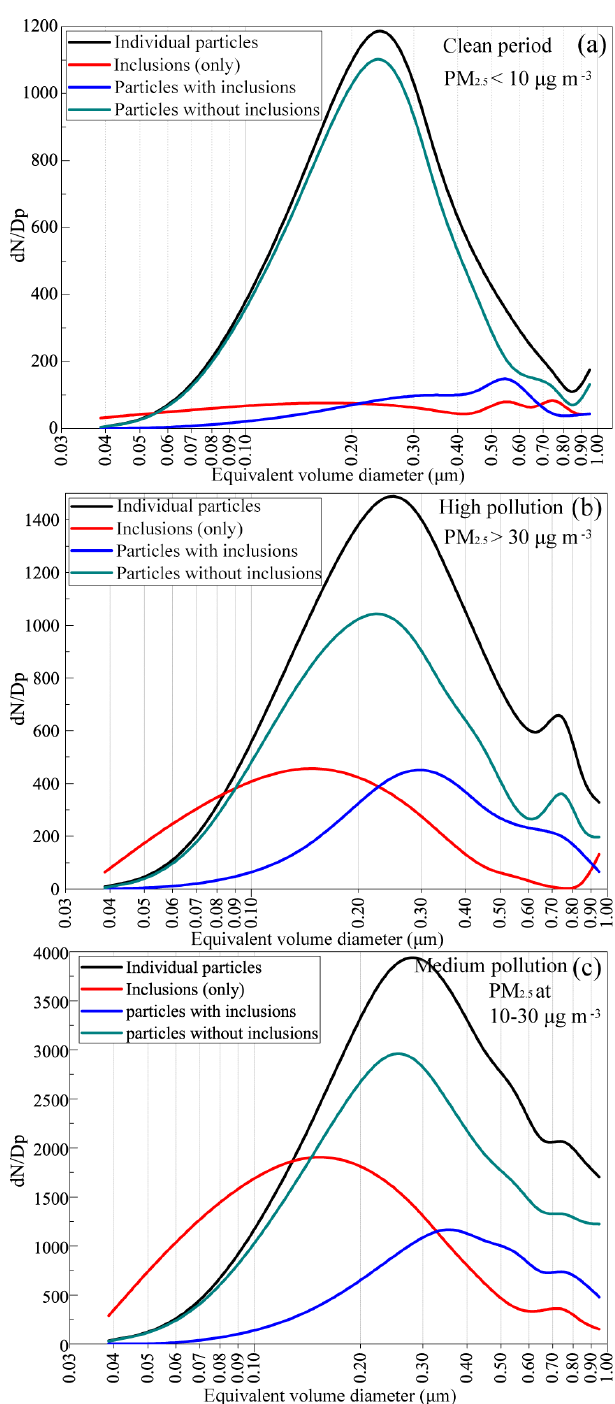
Figure 7. Size distributions of individual particles, inclusions, par- ticles with inclusions, and particles without inclusions. (a) Clean periods under PM 2 . 5 at 10µgm − 3 . (b) The high pollution level un- der PM 2 . 5 larger than 30µgm − 3 . (c) The medium pollution level under PM 2 . 5 between 10 and 30µgm − 3